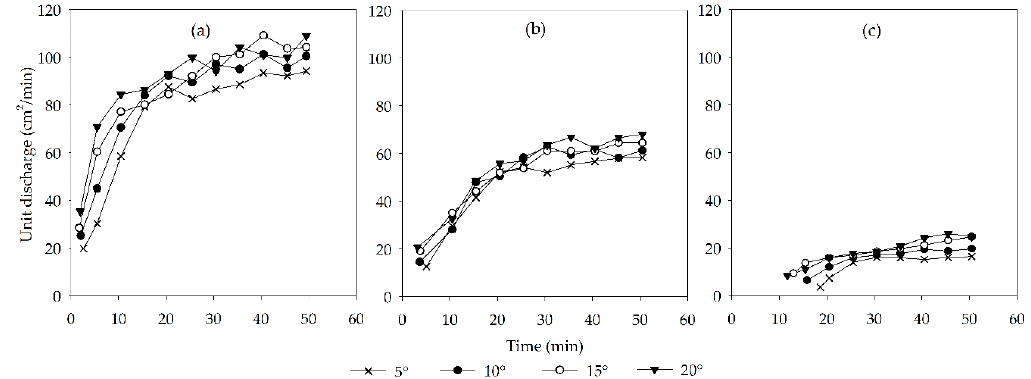
Figure 2. Unit discharge of runoff over rainfall time under different slope gradients and different rainfall intensities: ( a ) 75 mm/h, ( b ) 50 mm/h, ( c ) 25 mm/h.